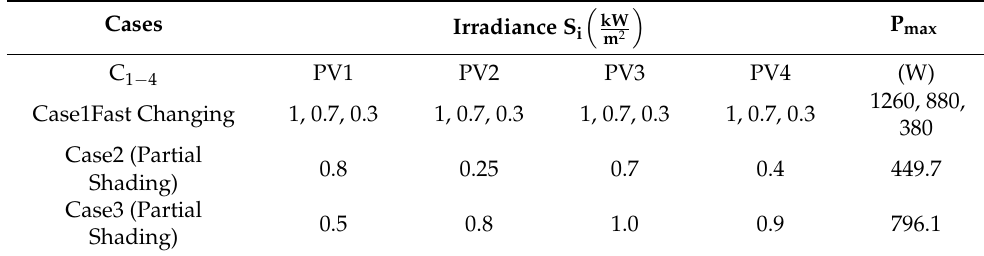
Table 2. Case 1 to Case 3: levels of irradiance.